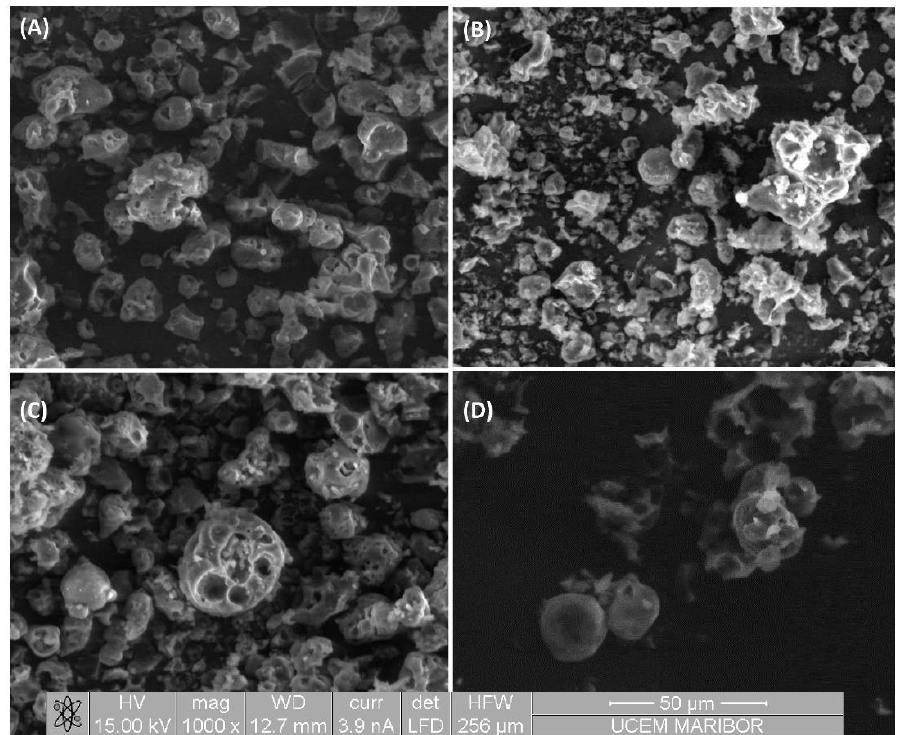
Figure 4. Environmental scanning electron microscope (ESEM) photographs of polyethylene gly- col microparticles of pigments of raw algal materials or extracts obtained with different extraction techniques: ( a ) raw algae material; ( b ) supercritical CO 2 extraction; ( c ) ethanol/water extraction; ( d ) conventional extraction.